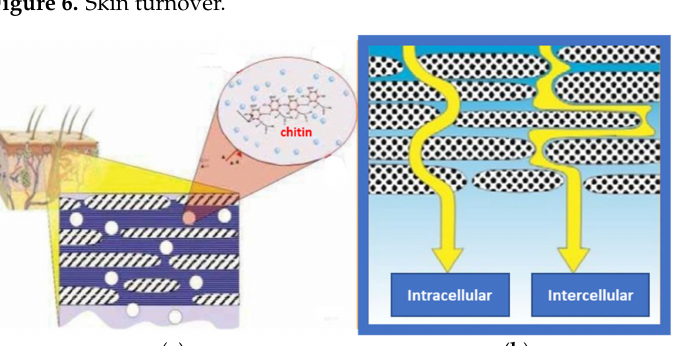
Figure 7. ( a ) skin penetration of chitin through the SC of the epidermis; ( b ) intracellular and intercellular penetration paths through